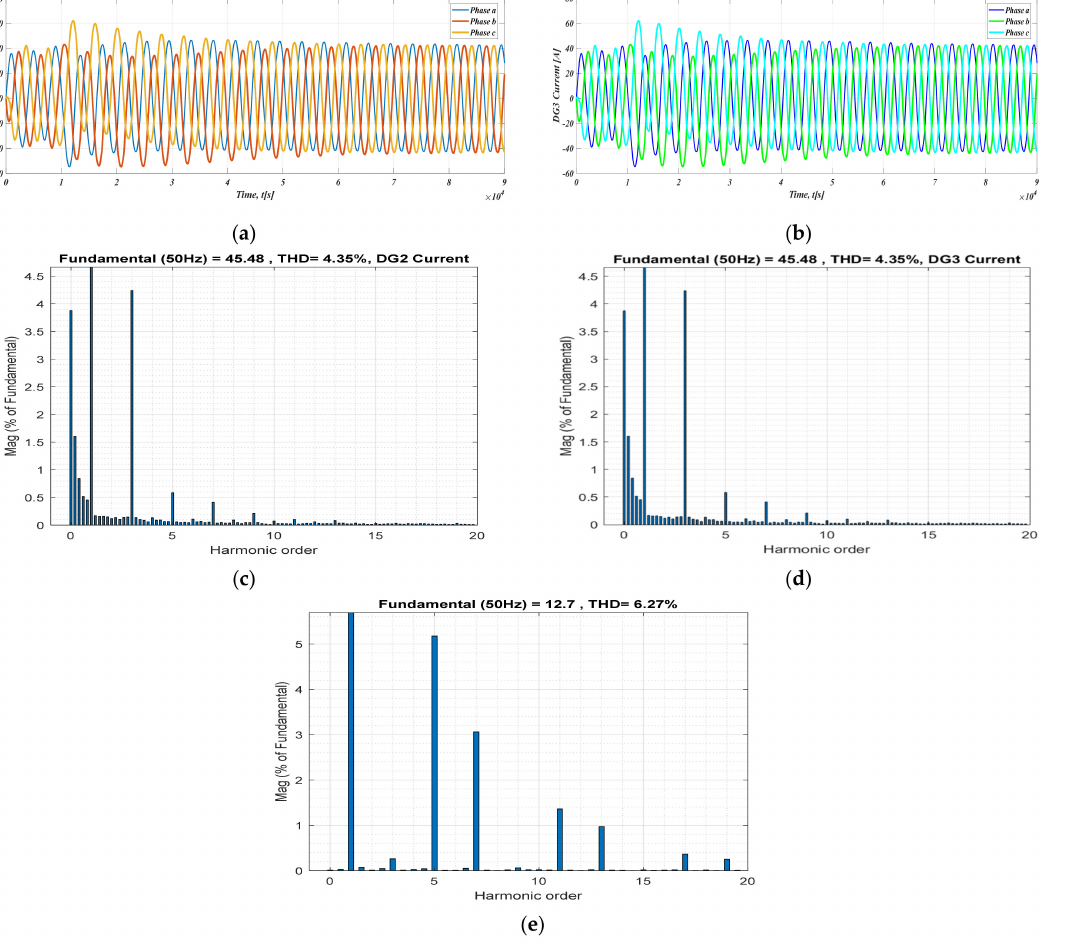
Figure 9. PI Controller system in Steady State Operation, ( a ) the Current of DG2, ( b ) the Current of DG3, ( c ) the THD analysis of the Load Current, ( d ) the THD analysis of DG2, ( e ) the THD analysis of the Load